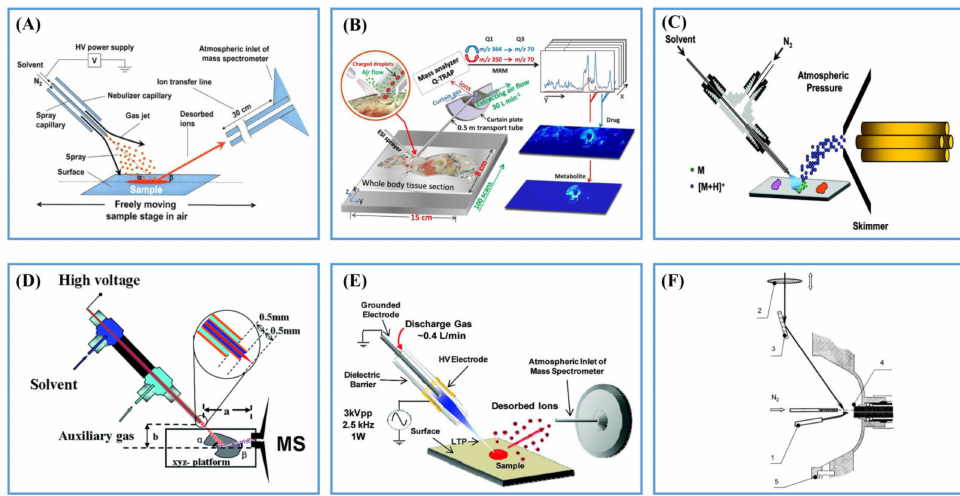
Figure 2. ( A ) Scheme of DESI ion source. Reprinted with permission from the authors of [4]. Copy- right (2004) American Association for the Advancement of Science. ( B ) Scheme of AFADESI